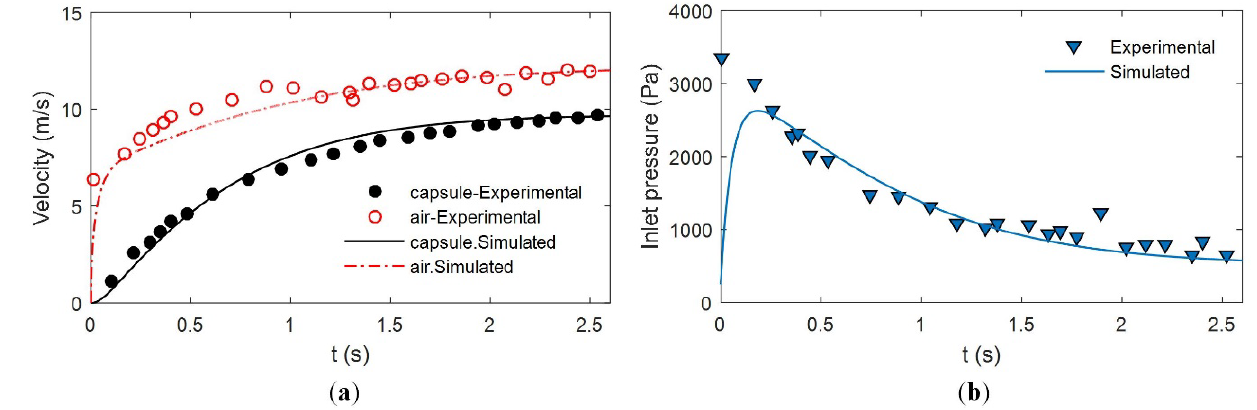
Figure 10. Comparison of simulated results with literature data: ( a ) capsule velocity and air velocity behind the start point of the capsule; ( b ) air pressure at the flow inlet.